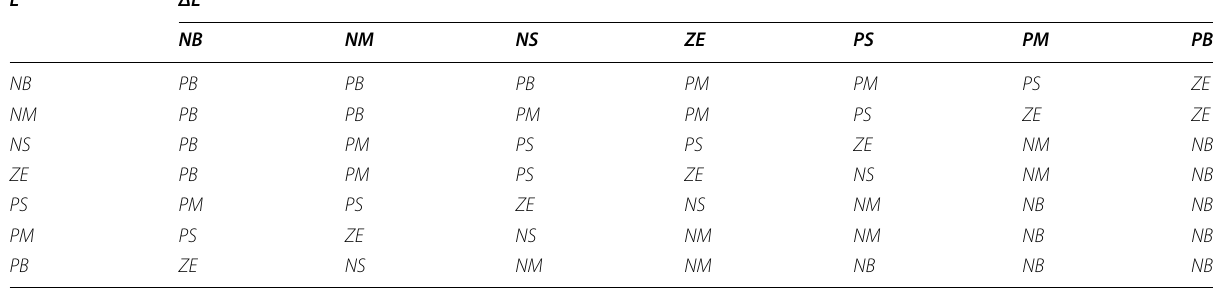
Table 1 Rule based representation